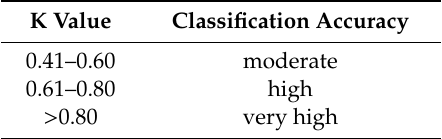
Table 2. Classification accuracy based on the kappa coe ffi cient (K